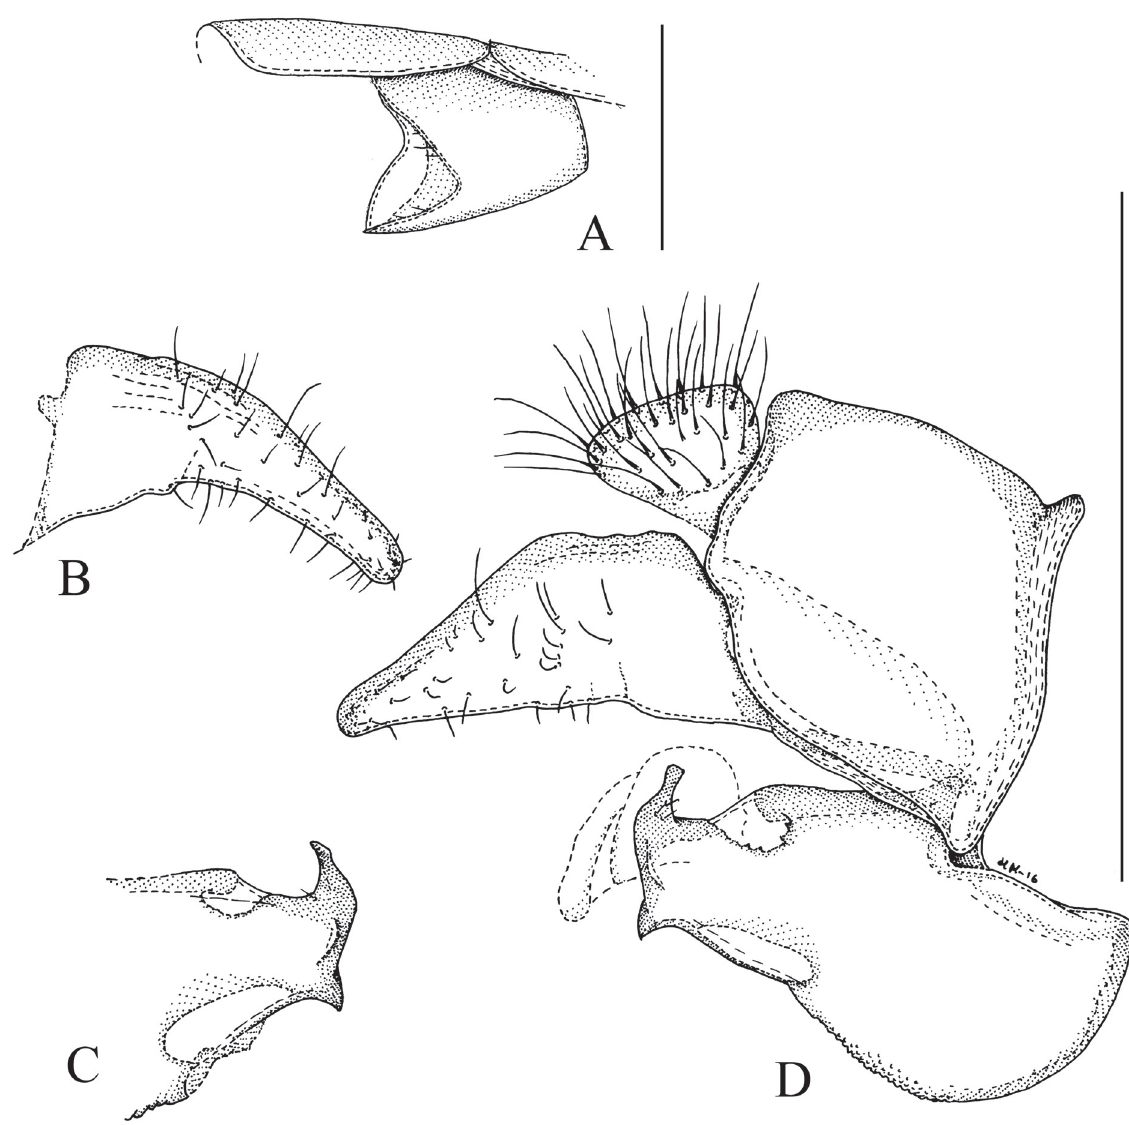
Fig. 1. Sphegina (Sphegina) abbreviata sp. nov., holotype, ♂ . A . Sternum IV with associated parts, right side, latero-ventral view. B . Left surstylus, lateral view. C . Left superior lobe, lateral view. D . Genitalia, right side, lateral view. Scale bar = 0.5